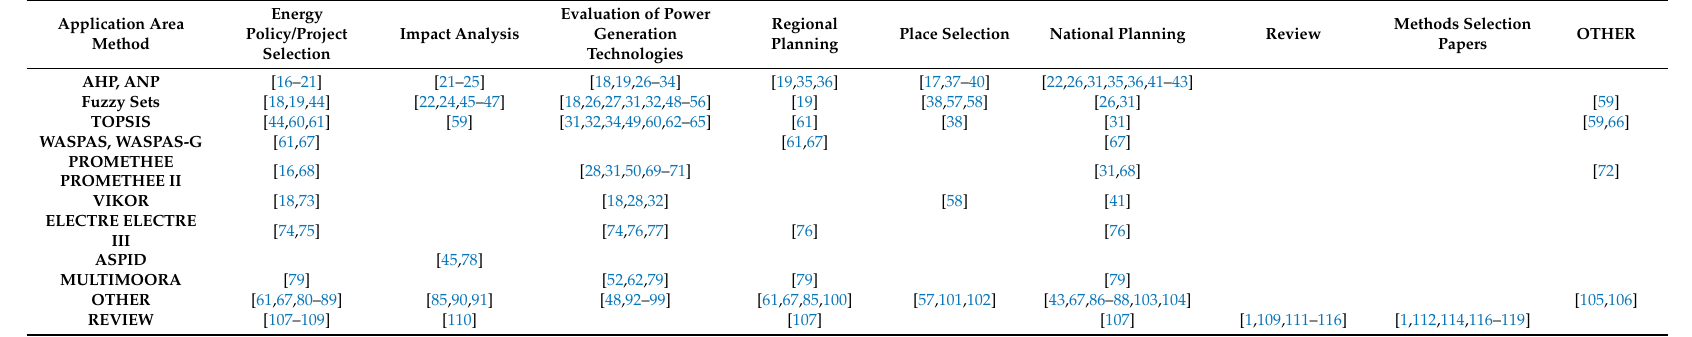
Table 4. The categorization of research by the application area and by the used method,